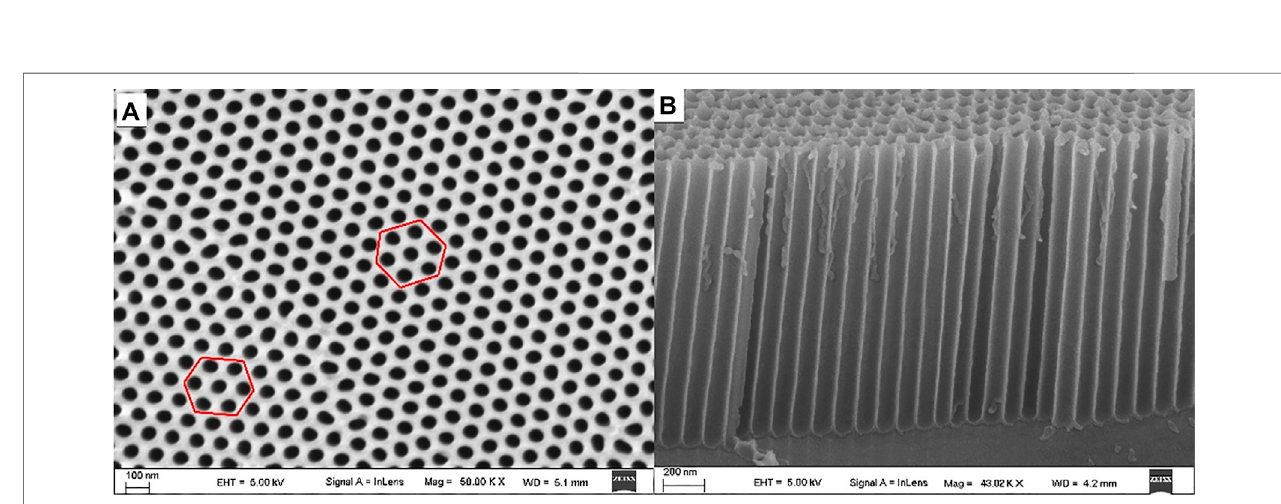
FIGURE 2 | SEM images of the PAA sample, from the top view (A) and the side view (B) . The hexagonal pore structure is clearly observed [1]. Reprinted with permission from [1] © The Optical Society.